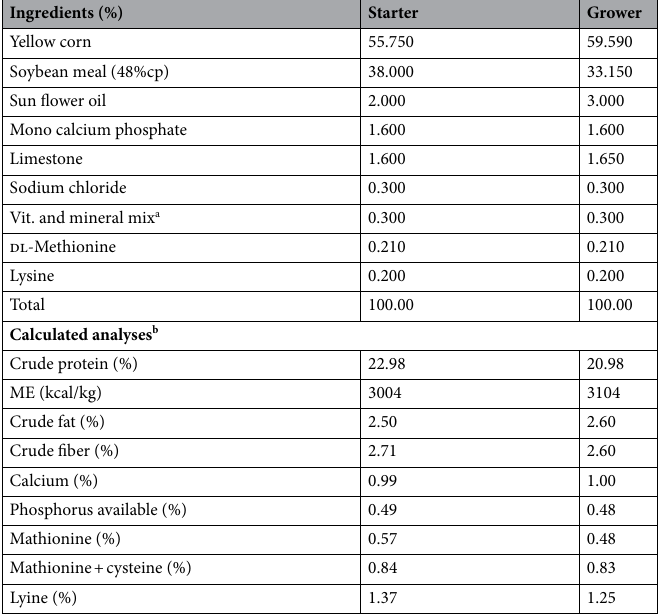
The temperature inside the house started at 33 °C at Day 1 and gradually reduced until it reached 31 °C after 2 weeks of age. Humidity ranged from 57 to 77% RH inside the house. Feed and water were offered ad libitum. The chicks were vaccinated against the Newcastle disease virus (NDV) using the HB1 strain combined with infectious bronchitis (IB) using the IB 120 strain at Day 7 and the LaSota strain only at Day 21. They were also vaccinated against infectious bursal disease using the D78 strain at Day 13. The chicks were fed with a starter diet from Day 1 to Day 28 and a growing diet from Day 29 to Day 35 32 (Table 1). The experimental diets were formulated according to the feeding stage: 23% of corn/soybeans in the starter diet (and standard protein requirement according to Nation Research Council (NRC) 33 and 21% of crude protein in the growing diet. The samples from each starter and growing diets were randomly collected for proxi- mate analysis in accordance with the procedure described by the Association of Official Analytical Chemists 34 . The dietary treatments were as follows: chicks in the control group were fed with basal diets without any addition and those in the other groups were fed with basal diets supplemented with 2, 4, and 8 of nano-silica- silver mg/kg, respectively. All of the chicks were reared in wire batteries under the same managerial, hygienic, and environmental conditions 35 . They were exposed to 23 h of continuous light per day during the experimental period. Feed and water were available ad libitum throughout the 6-week experimental period. Bodyweight and feed consumption were recorded. The feed conversion ratio was calculated (g feed/g gain). At the end of the experiment, blood samples were collected from the brachial veins of four chicks randomly chosen from each group. Serum was immediately centrifuged at 3500 rpm for 15 min and stored at − 18 °C until use. Evaluation of growth performance parameters. Live body weight, body weight gain, feed consumed, and feed conversion ratio (g feed:g gain) were recorded at 35 days of age for each replicate. No mortality was recorded during the whole experimental period. Physiological measurements. At 5 weeks of age, six chickens from each treatment were randomly taken and slaughtered, and blood samples were collected and divided into two equal parts: the first part was collected on heparin as anticoagulant (0.1 ml of heparin to 1 ml of blood) according to Hawk et al. 36 to determine the blood hematology (white blood cell counts (WBCs) and the differential of white blood cells, red blood cells (RBCs), hemoglobin concentration (Hb), and packed cell volume (PCV)), and the second part was immediately centri- fuged at 3500 rpm for 15 min and stored at − 18 °C until use.